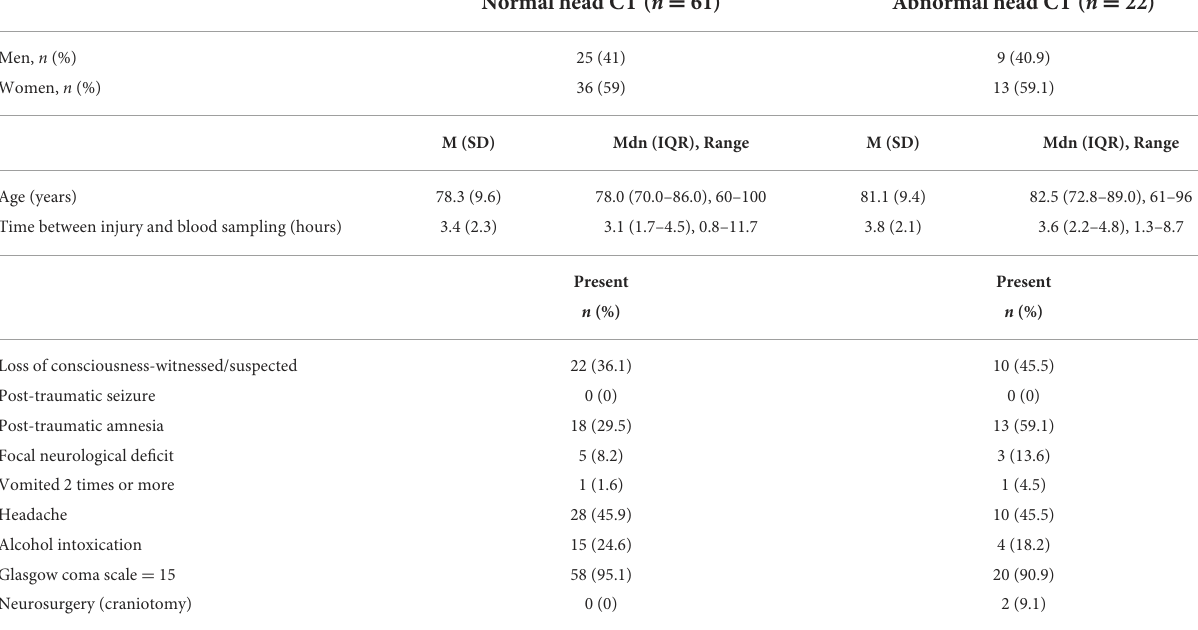
TABLE 2 Injury characteristics of the samples.